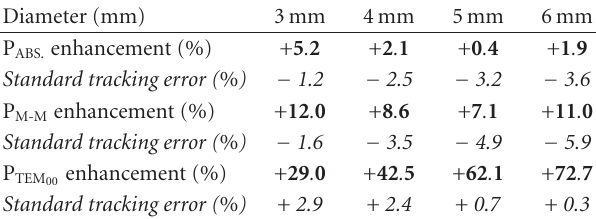
Table 3: Enhancements in the absorbed pump powers, the laser output powers, and the standard tracking errors achieved by the truncated cavity. Comparisons are made with the 3D-CPC-2D-CPC cavity. The positive values in bold signify the enhancement in the powers in percentage. The negative values in italic represent the reduction in standard 2mrad tracking errors in